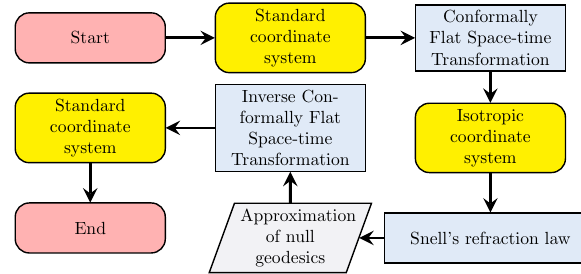
Fig. 2 Flowchart of the algorithm employed to compute the photon trajectories based on the Snell’s refraction law ( r , φ ) and momentum (cid:8) κ of a photon emitted with an emis- i i sion angle α in the standard spherical coordinate system